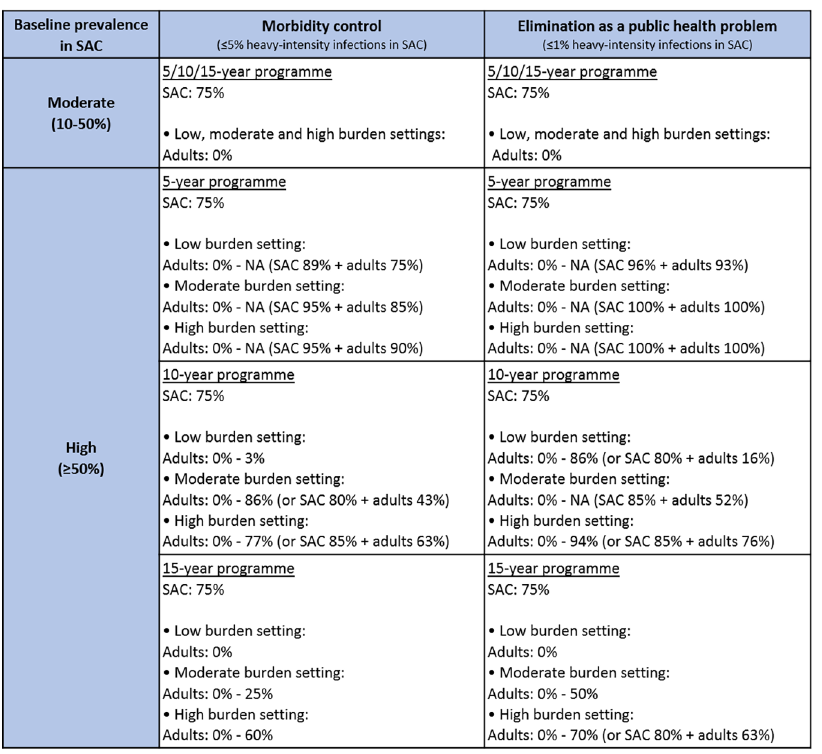
Fig 2. Coverage levels required to meet the World Health Organization (WHO) goals. Levels of school-aged children (SAC; 5–14 years of age) and adult ( (cid:21) 15 years of age) coverage required to meet the WHO goals when following currently recommended WHO treatment frequencies, i.e. for moderate baseline prevalence in SAC, treating once every 2 years; for high baseline prevalence in SAC, treating once a year. Required coverage levels are shown for a 5, 10 and 15-year treatment programme within low, moderate and high adult burden of infection settings. NA: not achievable unless SAC coverage is increased above 75%. More detailed S1–S3